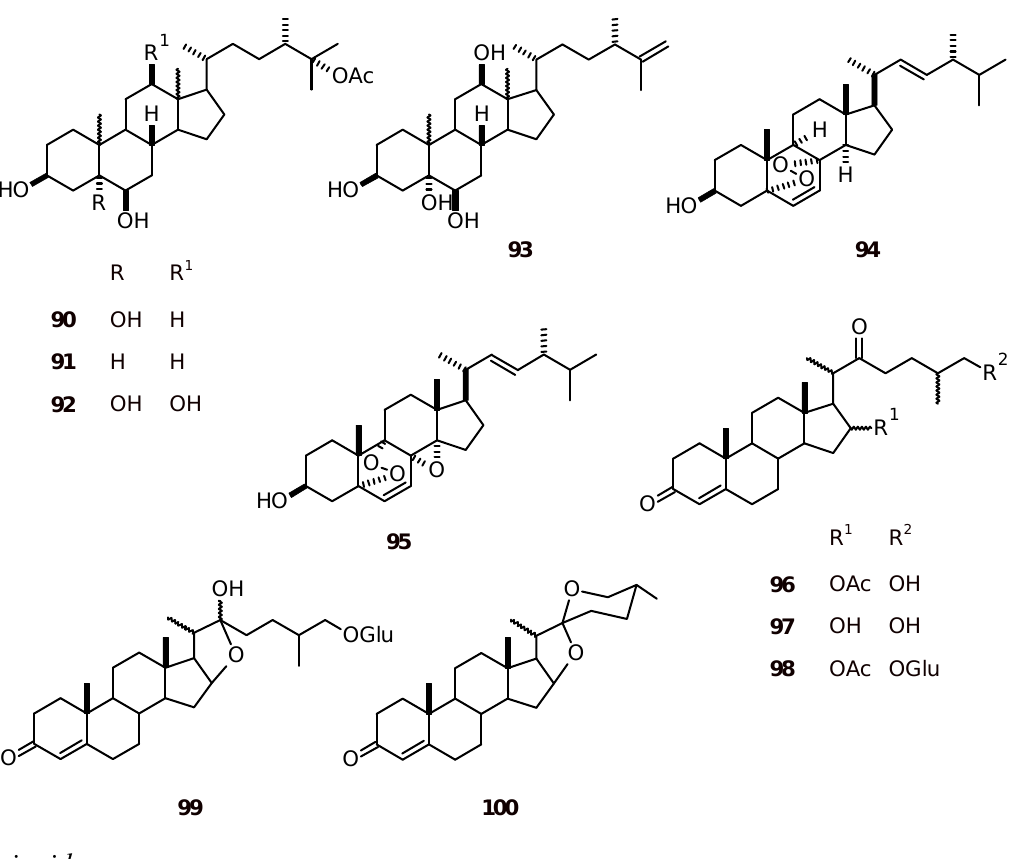
Figure 10. Structures of steroids 90 - 100